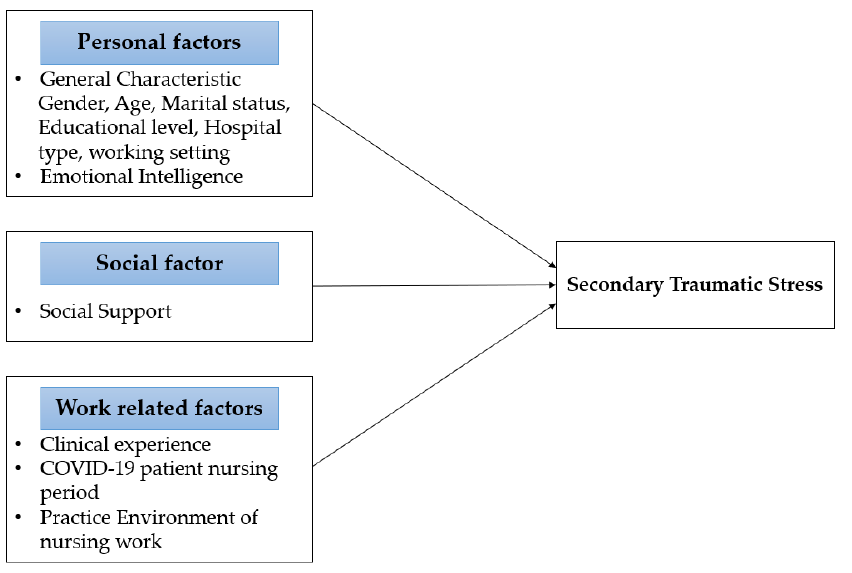
Figure 1. Conceptual